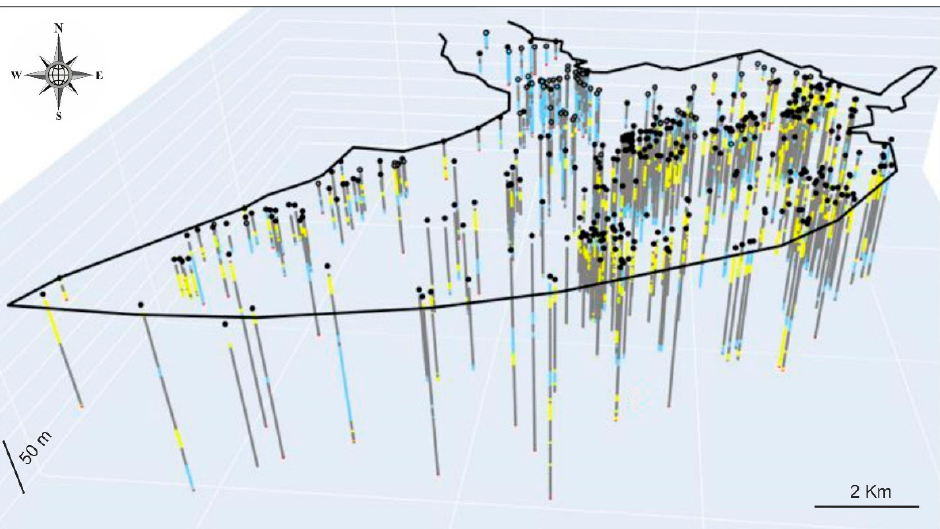
Figure 8. The 3D distribution of the granulometry classes along the Z axis in each of the 433 compiled boreholes in the LRD. The plotting adopted a 1:1:50 (x = 2, y = 2 and z = 0.5) aspect ratio for better display. The color assigned to each granulometry class is cyan for gravel, yellow for coarse sand, gray for silt–clay, and red for the basement. An interactive 3D HTML version of this model is provided as supplementary material (3D_Boreholes_LRD.html).